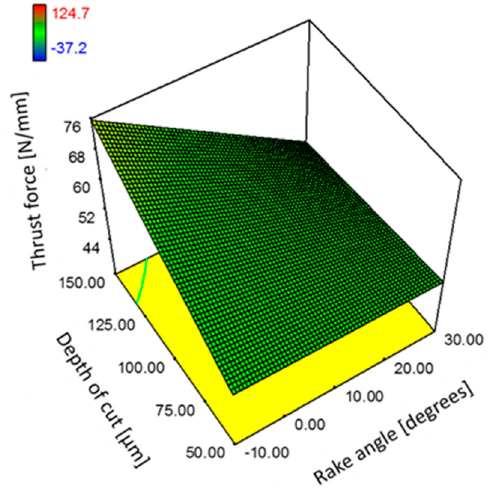
Figure 26. The combined effect of depth of cut and tool rake angle on the thrust force for samples with fibre orientation 90°.